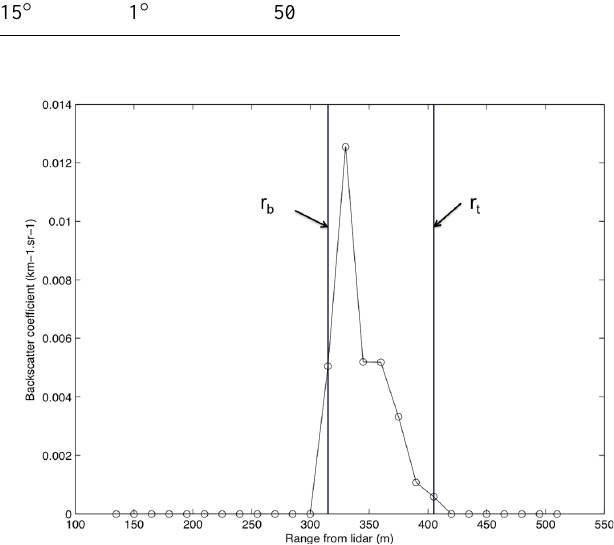
Fig. 3. Backscatter coefficient profile deduced from lidar measure- ments during Letia experiment. Vertical bars correspond to the smoke plume edge ( r b and r t ) from the